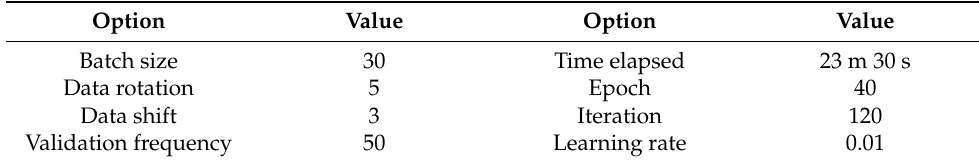
Table 3. Computational or time-complexity evaluation table of proposed